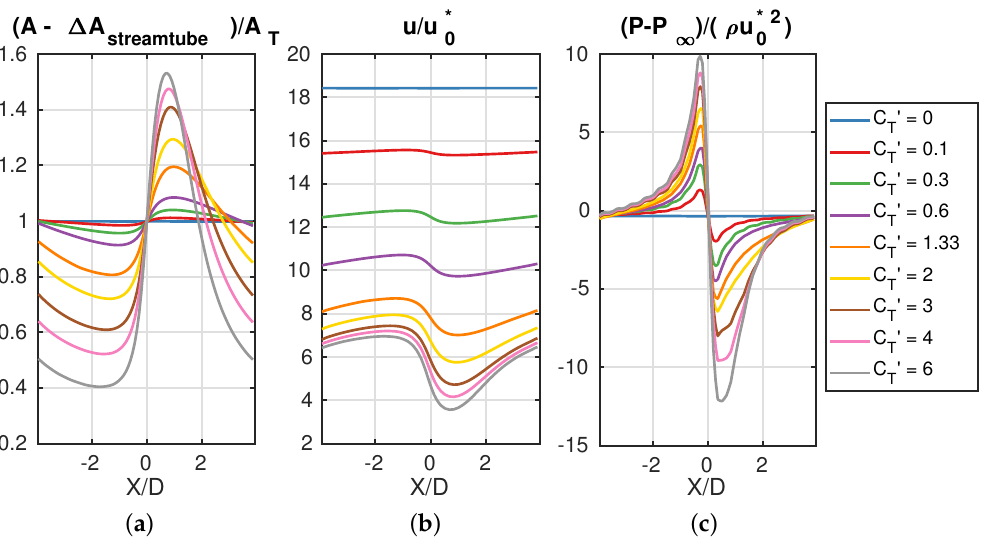
Figure 6. Streamtube properties for all wind farm cases ( a ) cross-sectional area. ( b ) mean streamwise velocity. ( c ) mean pressure. Velocity is normalized by the friction velocity from the no-turbines case ( u ∗ ). P ∞ is the hydrodynamic pressure at the top of the domain. ∆ A streamtube is the difference between 0 the area of the actuator disk and the streamtube, at the disk